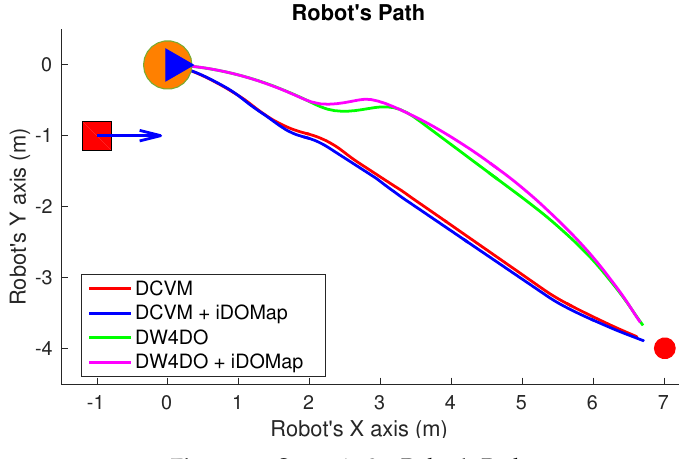
Figure 33. Scenario 3—Robot’s Paths.